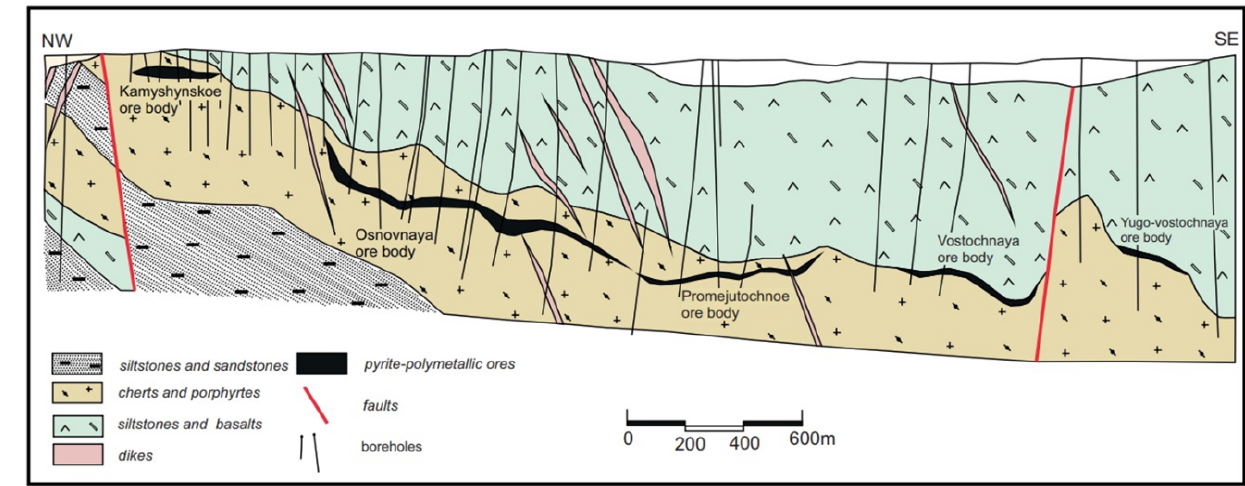
Figure 5. Cross section of the northeastern part of Artemiev deposit [34,47].